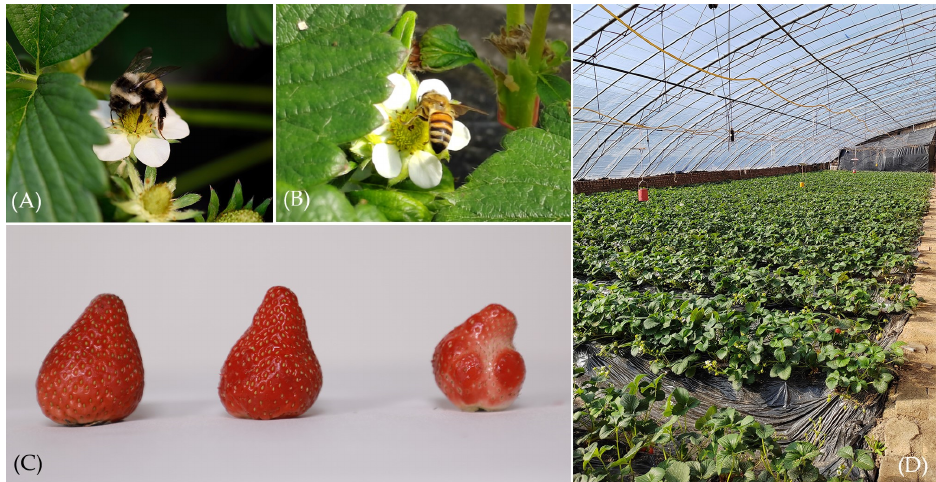
Figure 1. Bee pollinating for strawberries in the greenhouse and bee-pollinated fruits: ( A ) bumblebee foraging on a strawberry; ( B ) honey bee foraging on a strawberry; ( C ) left: A. mellifera pollinated fruit; middle: B. terrestris pollinated fruit; right: naturally pollinated fruit; ( D ) the greenhouse of F . × ananassa ‘Red Face’ (length × width × height: 94 m × 8 m × 4